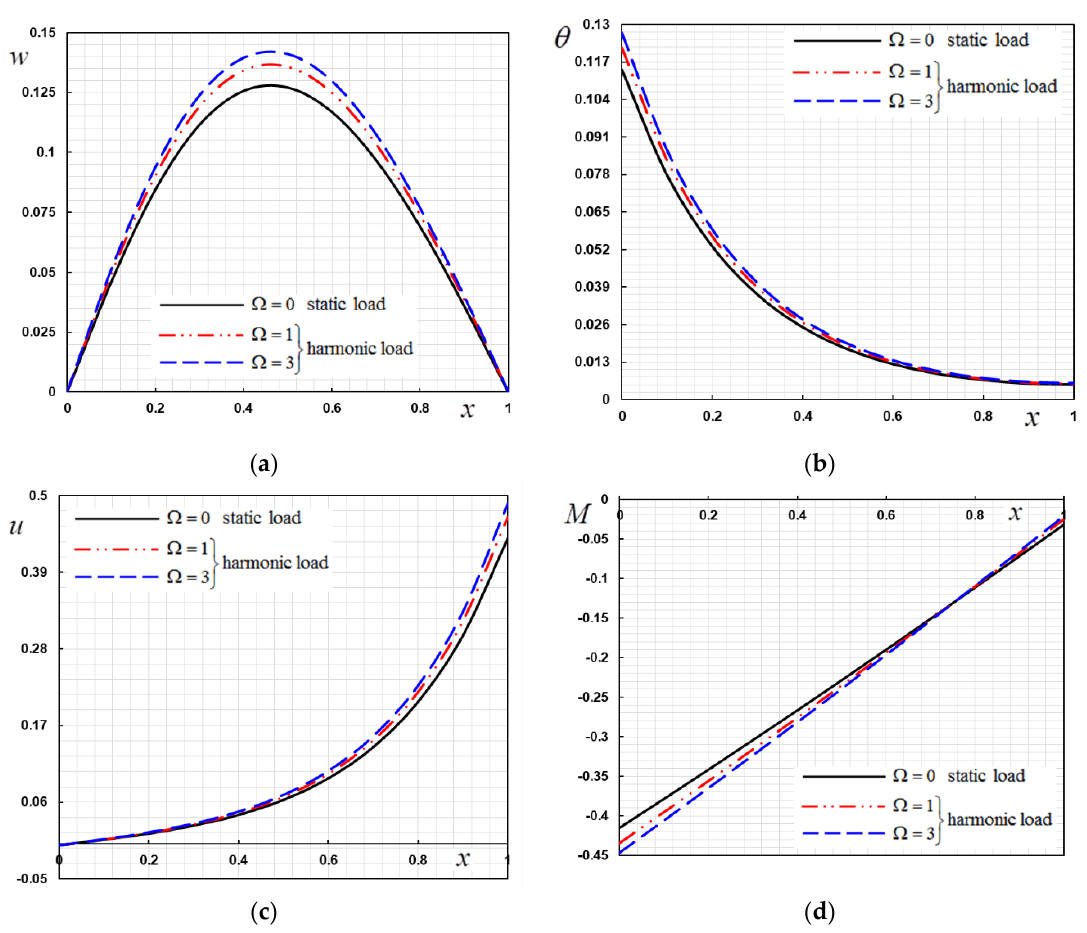
Figure 4. ( a ) The distribution of deflection w for different frequencies of the external excitation Ω ( b ): The distribution of temperature θ for different frequencies of the external excitation Ω . ( c ): The distribution of displacement u for different frequencies of the external excitation Ω . ( d ): The distribution of bending moment 𝑀 for different frequencies of the external excitation Ω